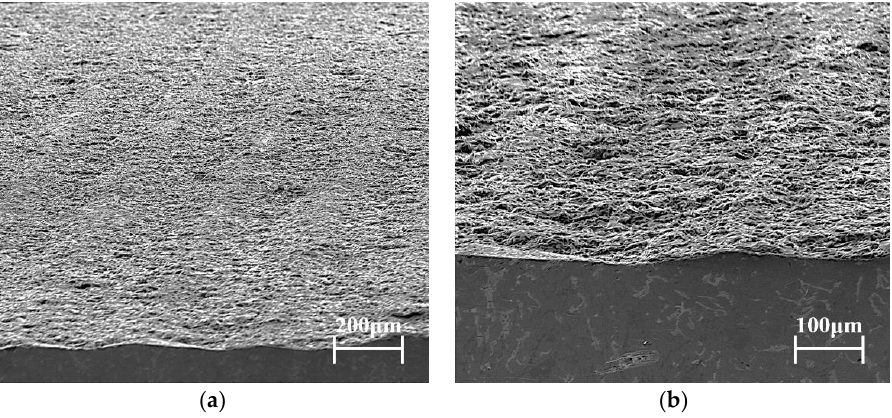
Figure 5. Cross-section morphologies of the skirt: ( a ) 200× magnification, ( b ) 500× magnification.